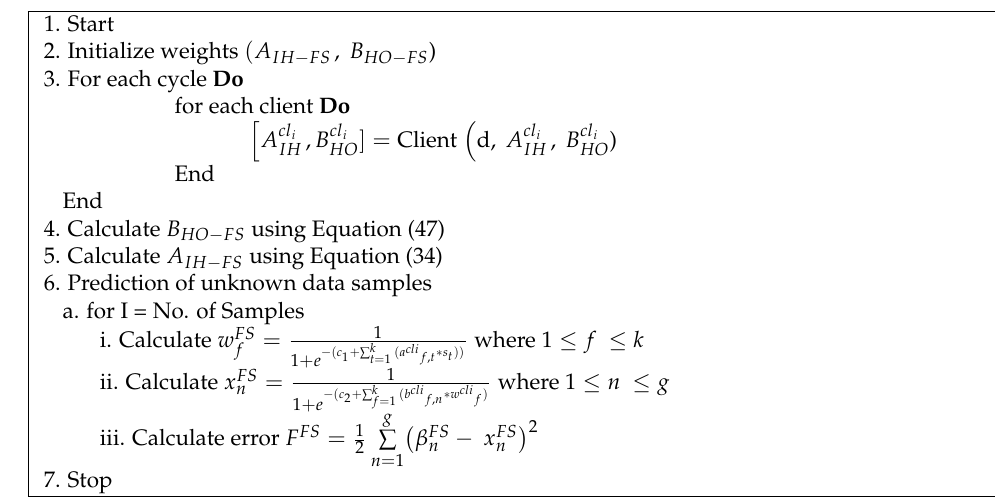
Table 2. Proposed weighted federated machine learning algorithm pseudo